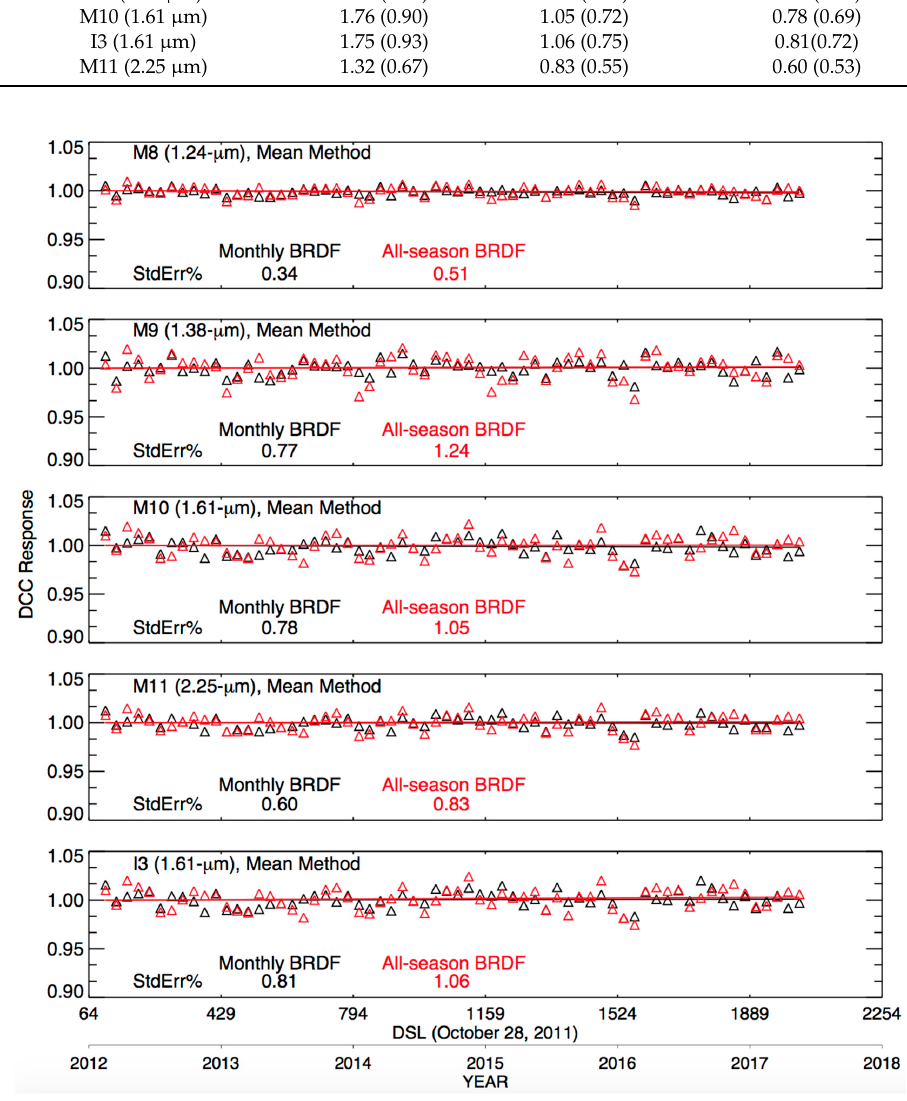
Figure 8. The normalized DCC Mean reflectance time series with either all-season ( red ) or monthly ( black ) DCC BRDF anisotropic corrections for VIIRS SWIR bands with corresponding linear trend lines and standard error in percent.